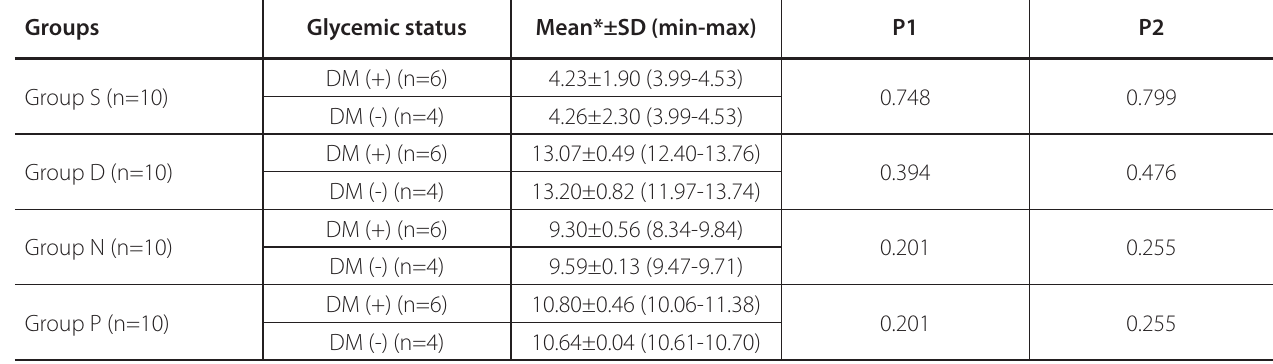
Table 3 . Comparison between diabetic and non-diabetic patients’ samples within groups.